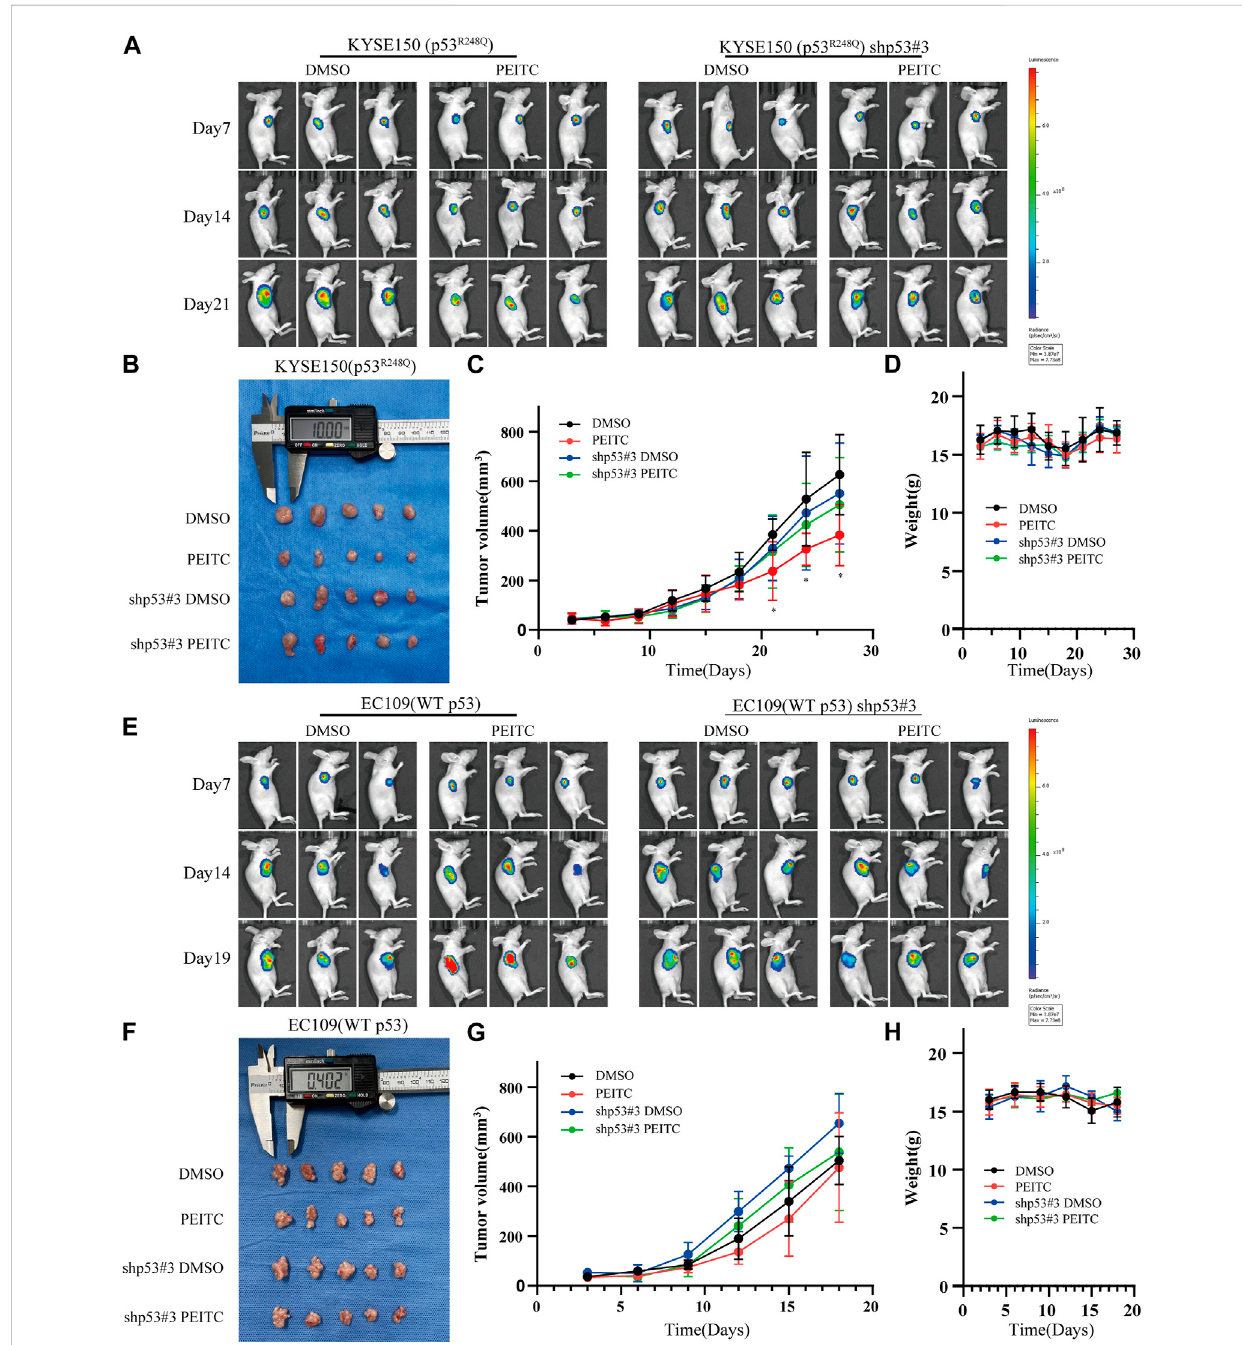
FIGURE 5 PEITCinhibitsKYSE150xenografttumorgrowth. (A,E) Tumorgrowthmeasuredby invivo luciferaseimagingofxenograftsposttransplantation. (B,F) Tumor volumes of xenografts when the mice were killed. (C, G) Changes in tumor volume over time. (D, H) Changes in body weight of mice with time. * p < 0.05.